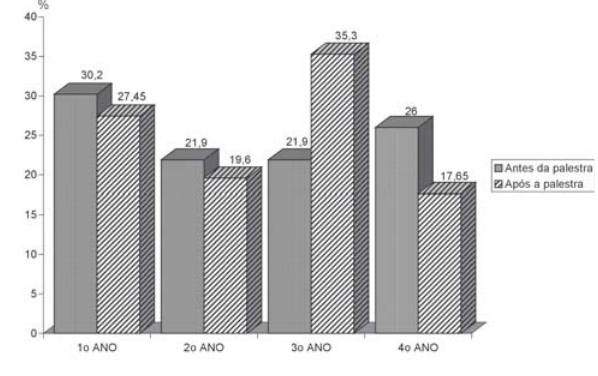
FIGURA 2 - Representabilidade de cada série quanto às respostas ao questionário antes e após a palestra